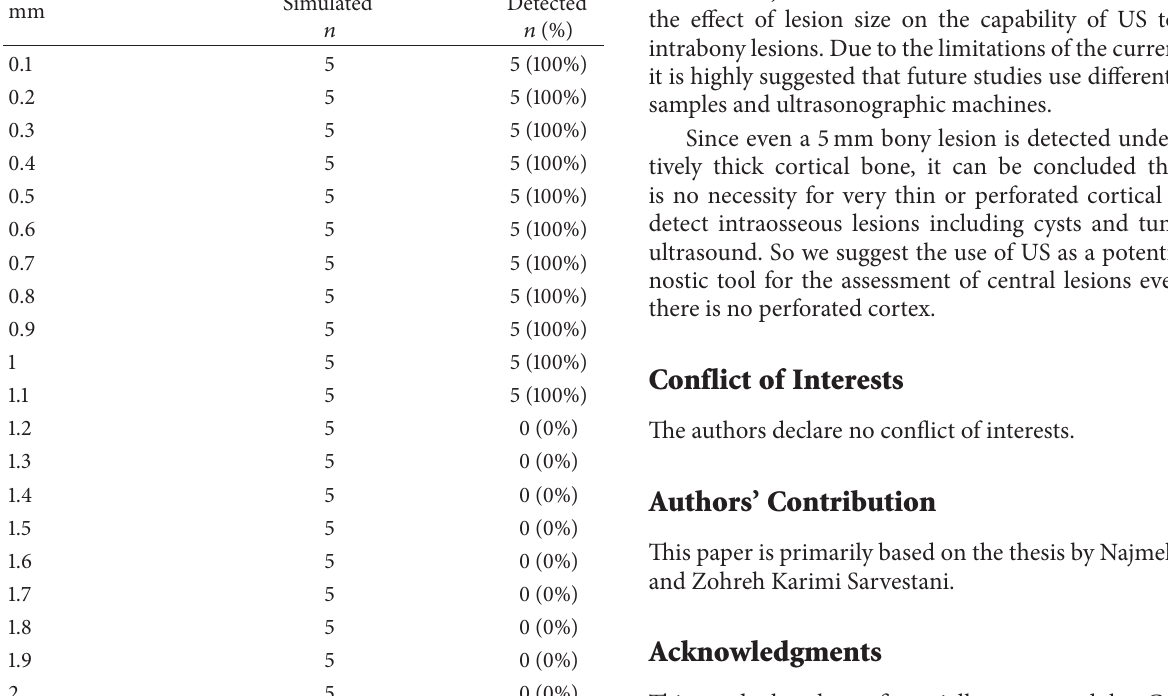
Table 1: Number of detected cavities in different bone thicknesses. Bone